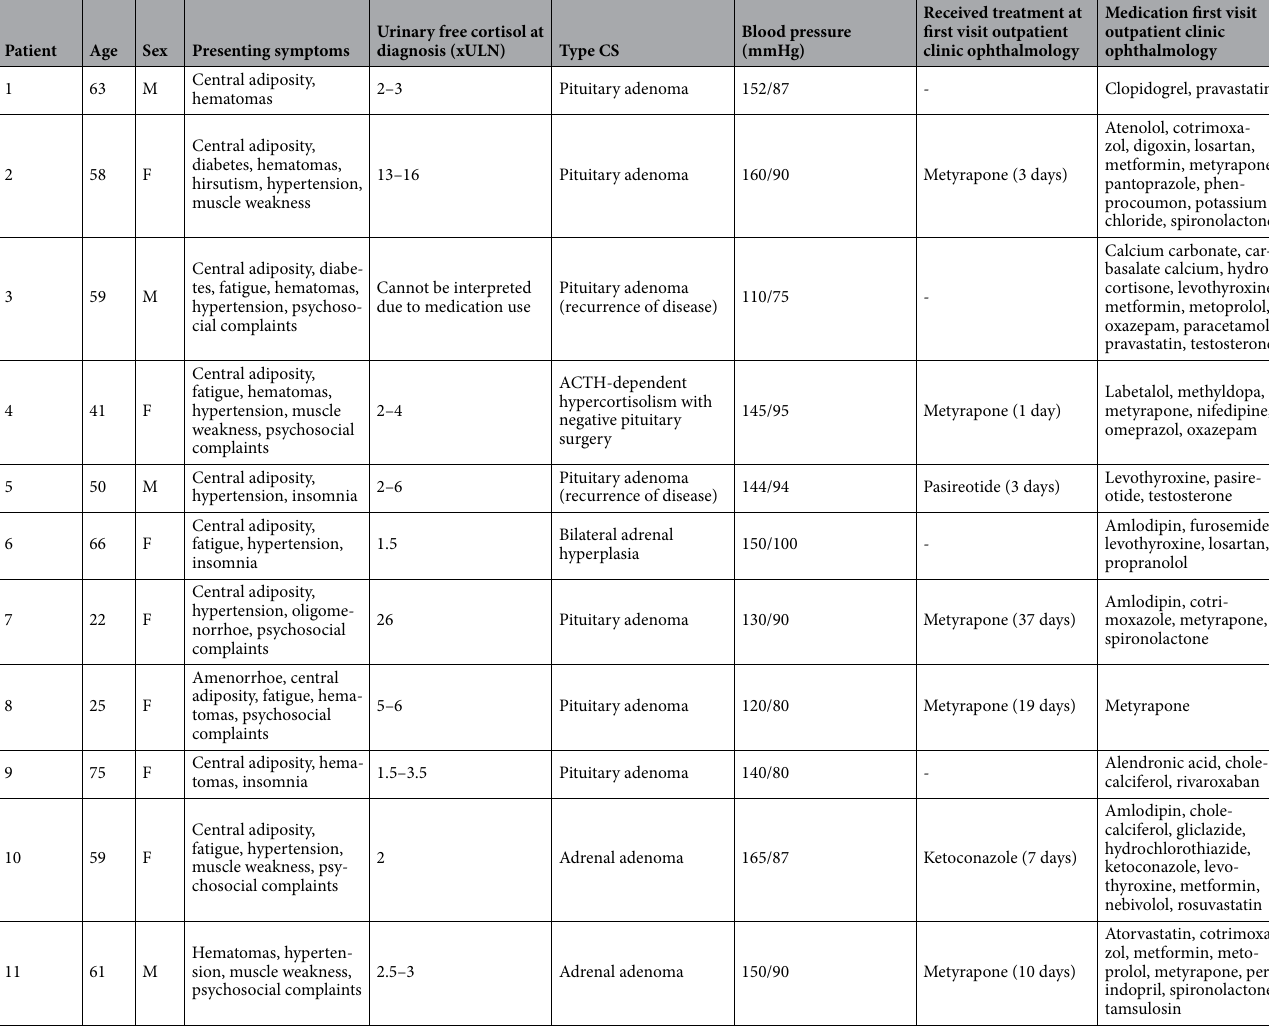
Table 1. Clinical characteristics of patients with active Cushing’s syndrome. ACTH adrenocorticotropic hormoneadrenocorticotropic hormone, CS Cushing’s syndrome, xULN x upper limit of